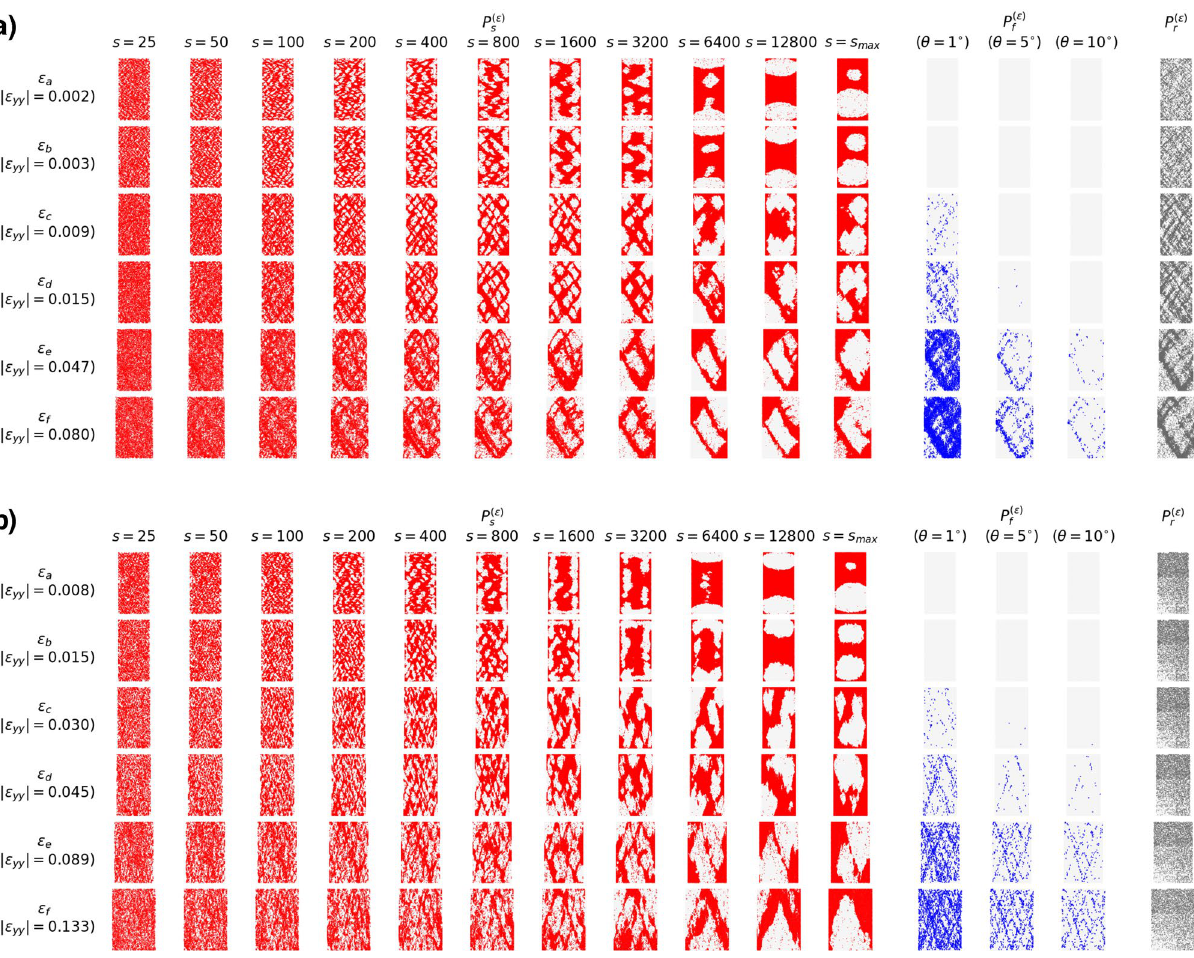
(ε) s ), and two other widely used